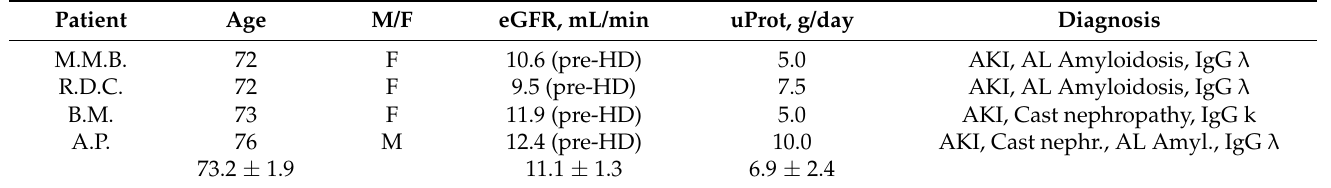
Data are expressed as mean ± SD. Abbreviations: eGFR, estimated glomerular filtration rate (CKD-EPI equation); uProt, proteinuria; MM, multiple myeloma; HD,